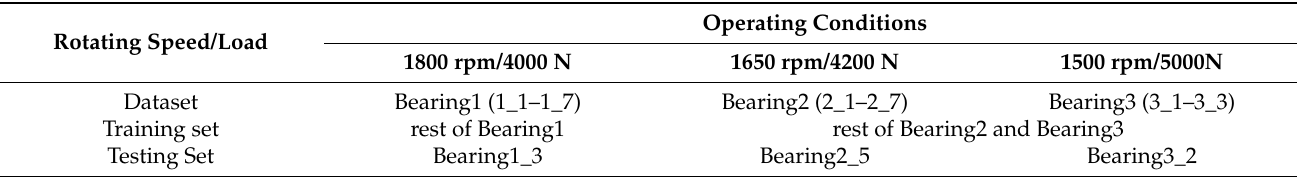
Table 1. Detailed information of PHM2012